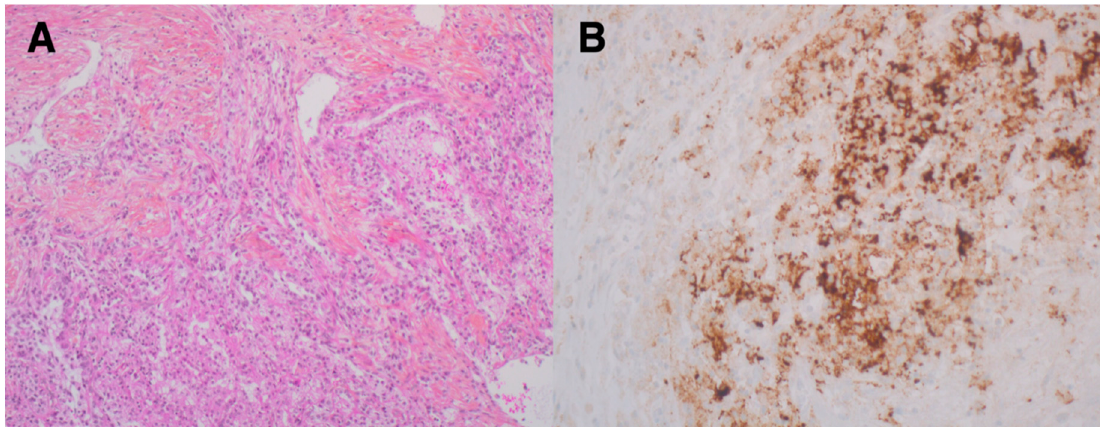
Figure 1. ( A ) Hematoxylin/eosin and phloxin staining for clear-cell RCC (ccRCC) with sarcomatoid features (50× magnification), considered as grade 4 according to the International Society of Urologic Pathologists (ISUP). ( B ) High PD-L1 (100× magnification) (E1L3N XP Rabbit mAB) cytoplasmatic staining of tumor cells in sRCC (>50% of tumor cells).